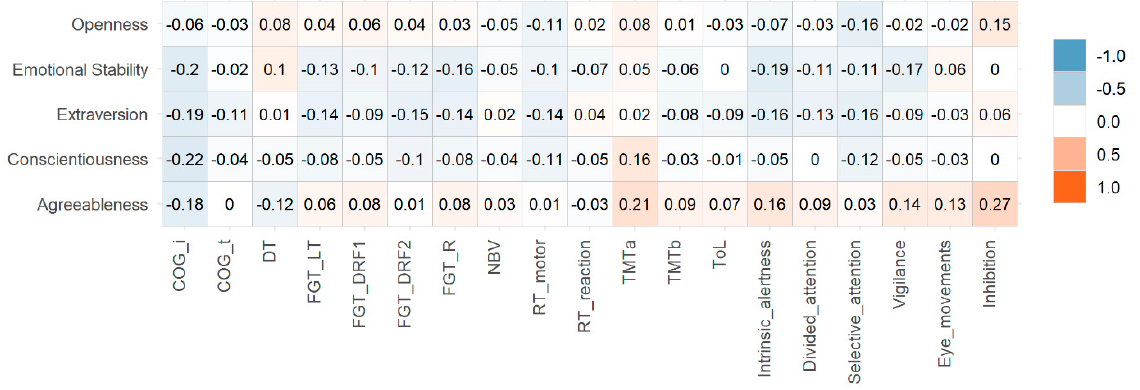
Figure 3. Heatmap of Pearson correlation coefficients between computerized neuropsychological tests and personality factors. COG: Cognitrone (i: incorrect reactions; t: mean time); DT: determination test; FGT: Figural memory test (LT: Learning total; DRF1: delayed free recall 1; DRF2: Delayed Free Recall